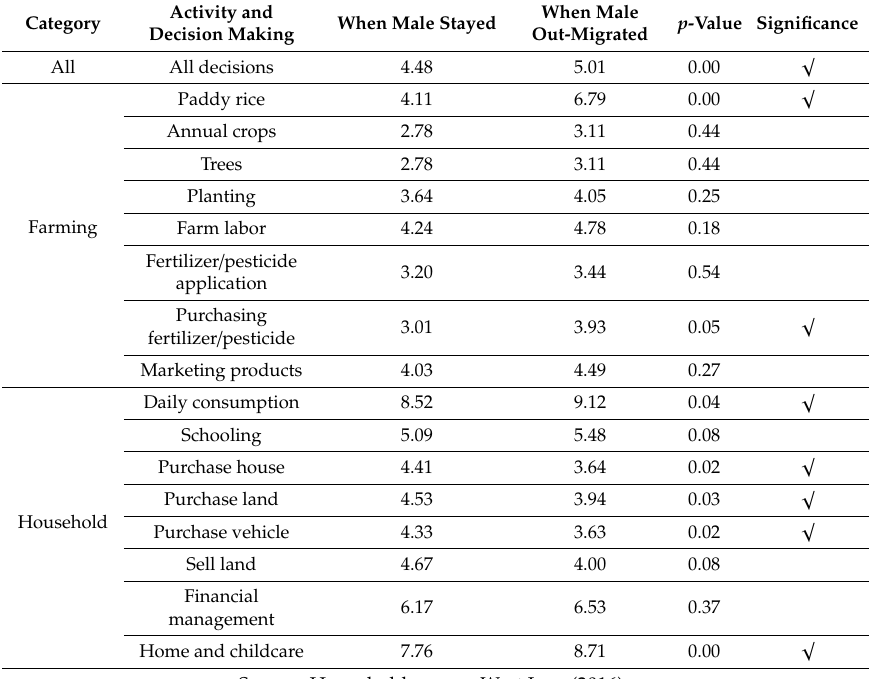
Table 4. Women’s workload and power related to decision making based on di ff erent periods, West Java.